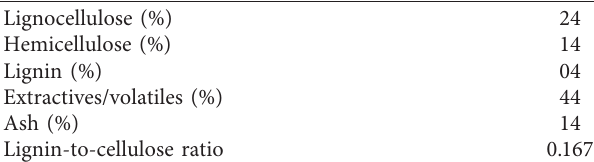
Table 2: Fibre analysis of fresh cattle dung. Table 3: Isolated microbial